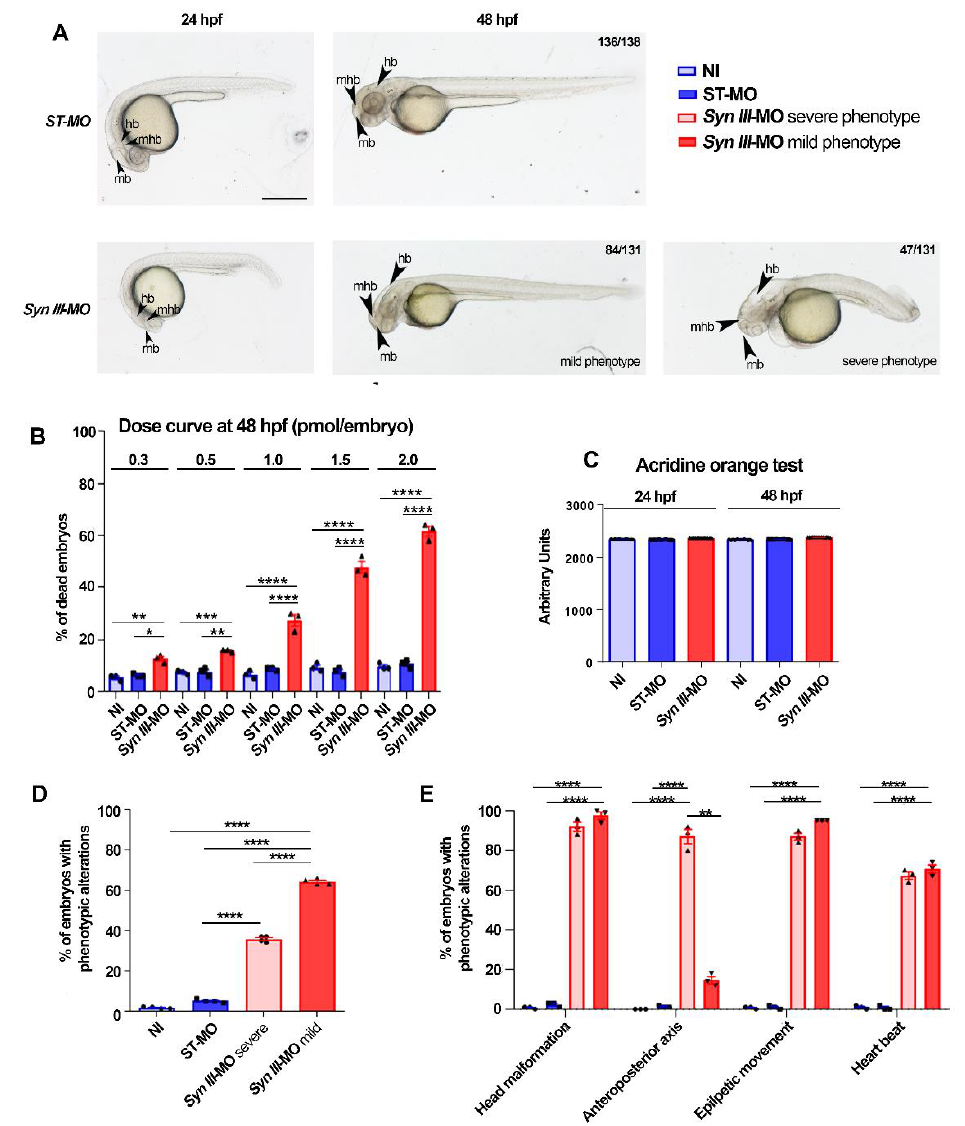
Figure 1. Phenotypic alterations in Syn III -MO-injected zebrafish. ( A ) Representative images of ST-MO- or Syn III -MO-injected embryos at 24 and 48 hpf. Syn III -MO-injected morphants exhibited mild or severe phenotype at 48 hpf. Scale bar, 500 µ m. Abbreviations: mb, midbrain; hb, hindbrain; mhb, midbrain hindbrain boundary. ( B ) Ascending doses (in pmol/embryos) of Syn III -MO produced significant progressive increase in the percentage of dead embryos that was comparable in ST-MO and control non-injected (NI) embryos. (* p < 0.05, ** p < 0.01, *** p < 0.001, **** p < 0.0001 One-way ANOVA + Newman-Keuls, n = 3 experimental replicates represent the % mean of dead embryos per group from three experiments including at least 20 embryos per group). ( C ) Acridine orange fluorescence intensity (in arbitrary units) in the embryos injected with 1.0 pmol/embryo of ST-MO or Syn III -MO when compared to NI embryos at 24 and 48 hpf (One-way ANOVA + Newman-Keuls. n = 4 experimental replicates represent the mean fluorescence intensity per group in four experiments including at least 10 embryos per group). ( D ) At 48 hpf a significantly higher percentage of syn3